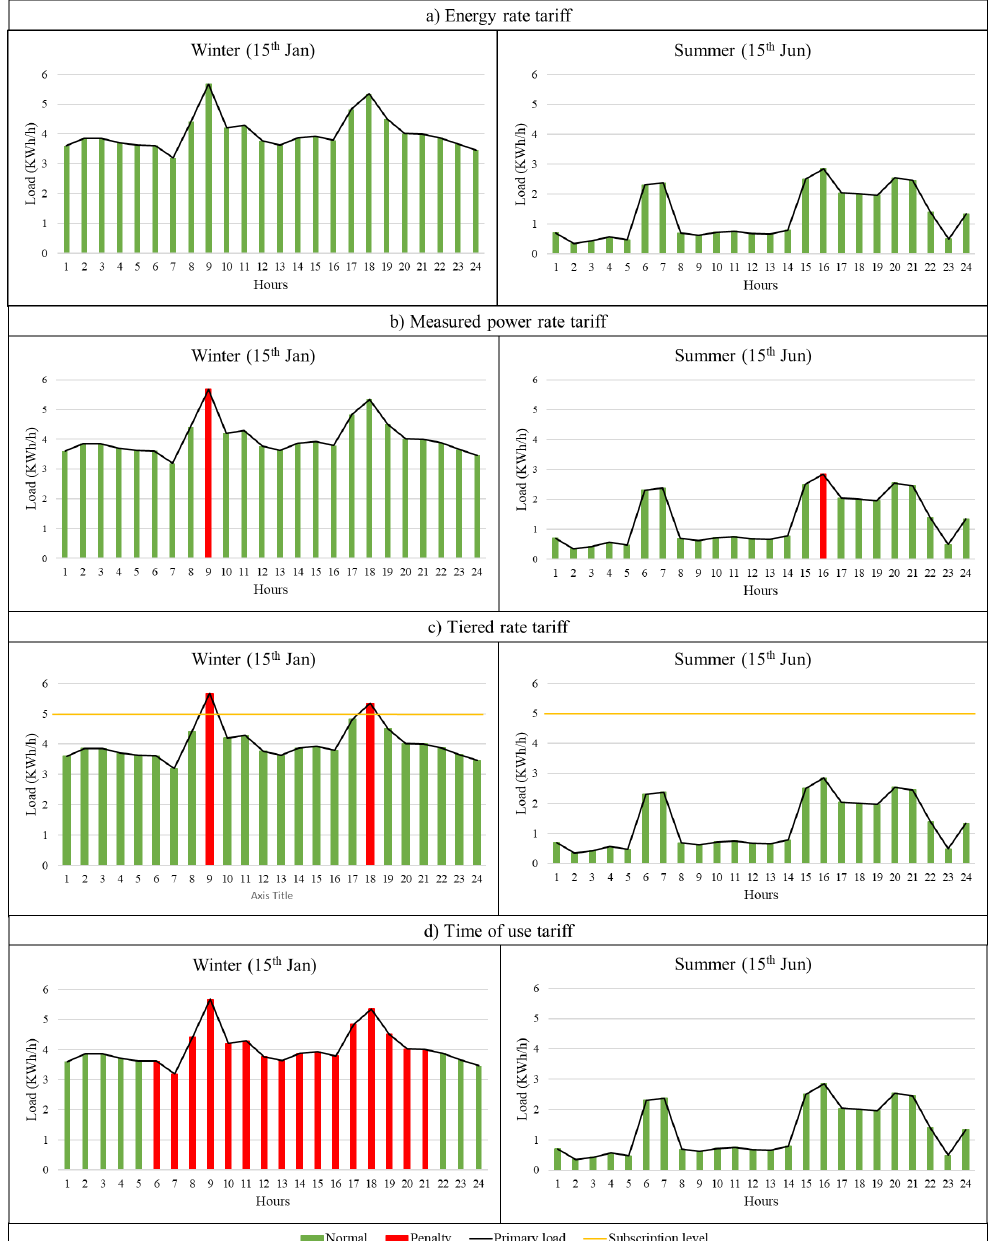
Figure 2. Illustration of: ( a ) Energy rate tariff, ( b ) measured power rate tariff, ( c ) tiered rate tariff, and ( d ) time of use tariff in typical winter and summer days. The illustration shows hourly loads over 24 h for the example single-family house. The penalized hours in each tariff are shown in